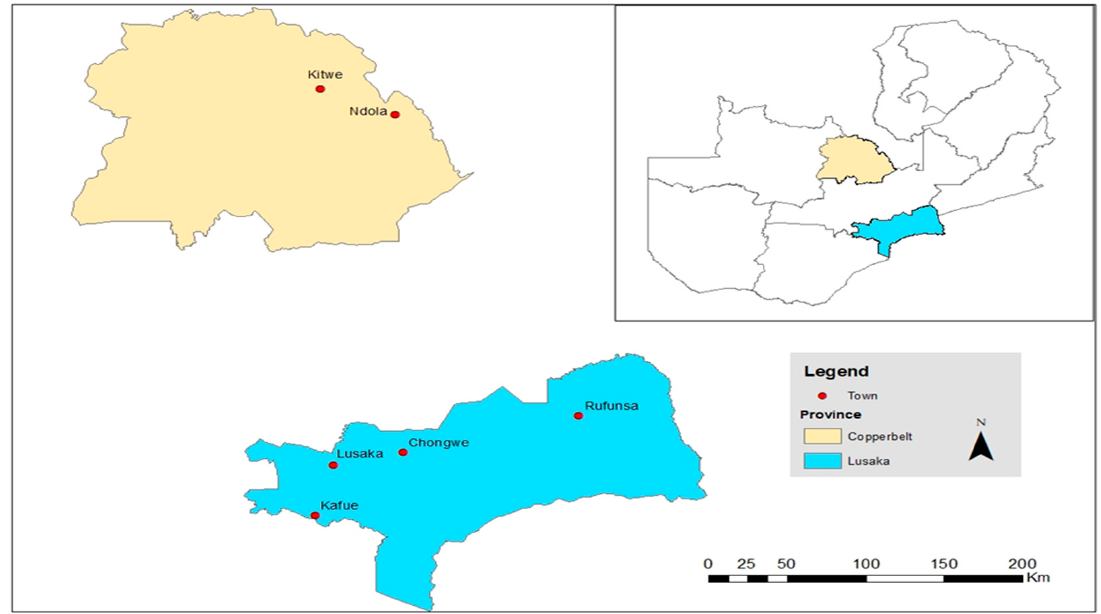
Figure 1. Map of Zambia indicating the sampling sites.